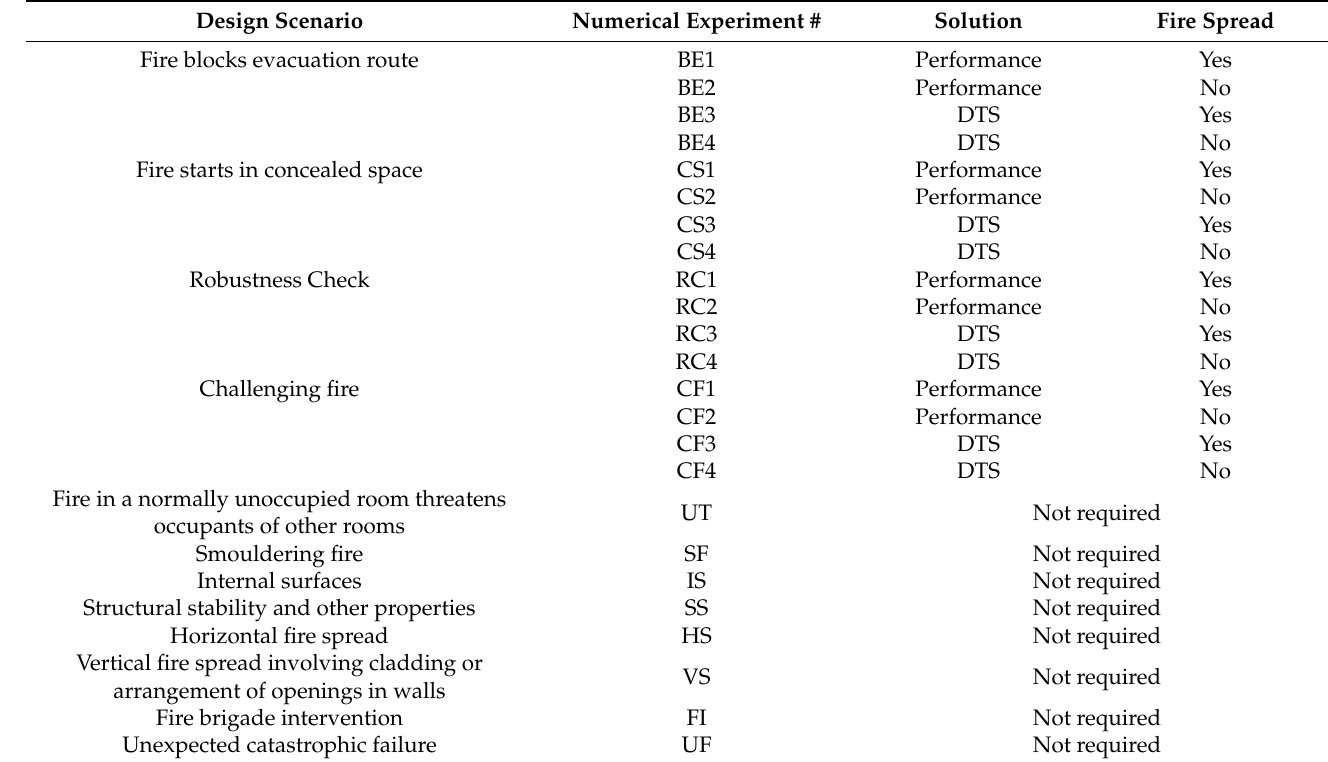
Table 3. Table of experiments for FSVM design